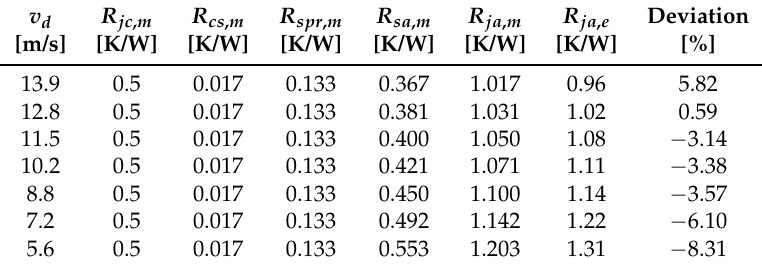
Table 3. Comparison between experimental results ( R ja , e ) and model predictions ( R ja , m ) for the considered commercial heat sink for different values of approach velocity ( v d ), with corresponding R ja , m − R ja , e · 100) between model and experiments. percent deviations ( R ja , e v d R jc ,